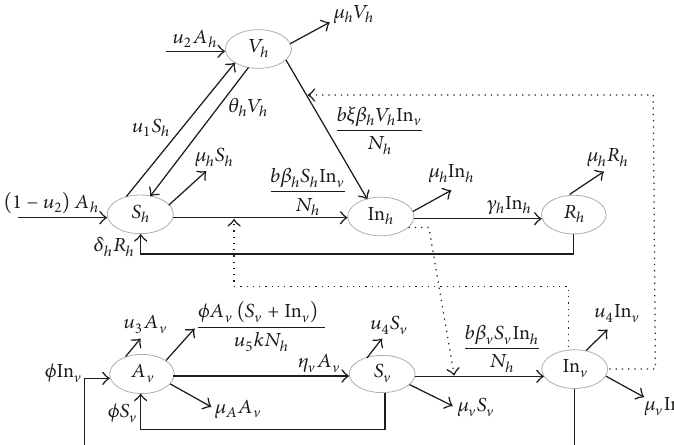
Figure 1: Mathematical model using vaccination of adults and newborns, fumigation and larvicide treatment, and enforcement of mechanical